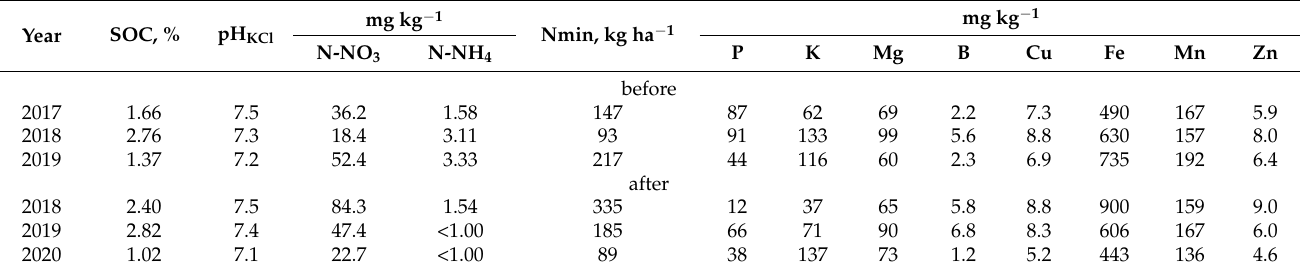
Table 7. Soil properties before establishing the experiment with sugar beet and after the harvesting